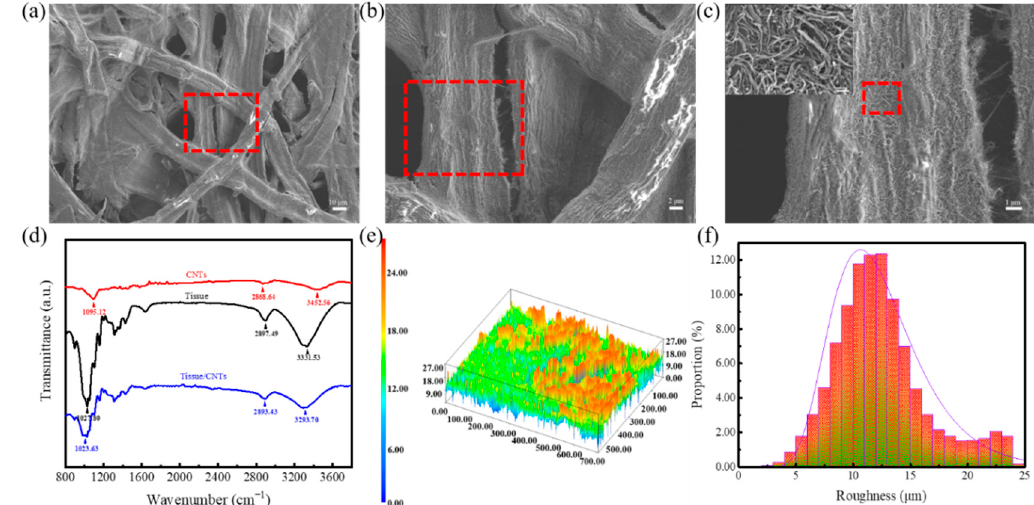
Figure 2. Composition characterization of the all-tissue-based pressure sensor. ( a , b ) Surface morphology of tissue/CNT composites. ( c ) Adhesion of CNTs to a single fiber. ( d ) FTIR results of CNT, tissue, and tissue/CNT composites. ( e ) 3D surface profile of tissue/CNT composites. ( f ) The proportion distribution of the surface roughness.